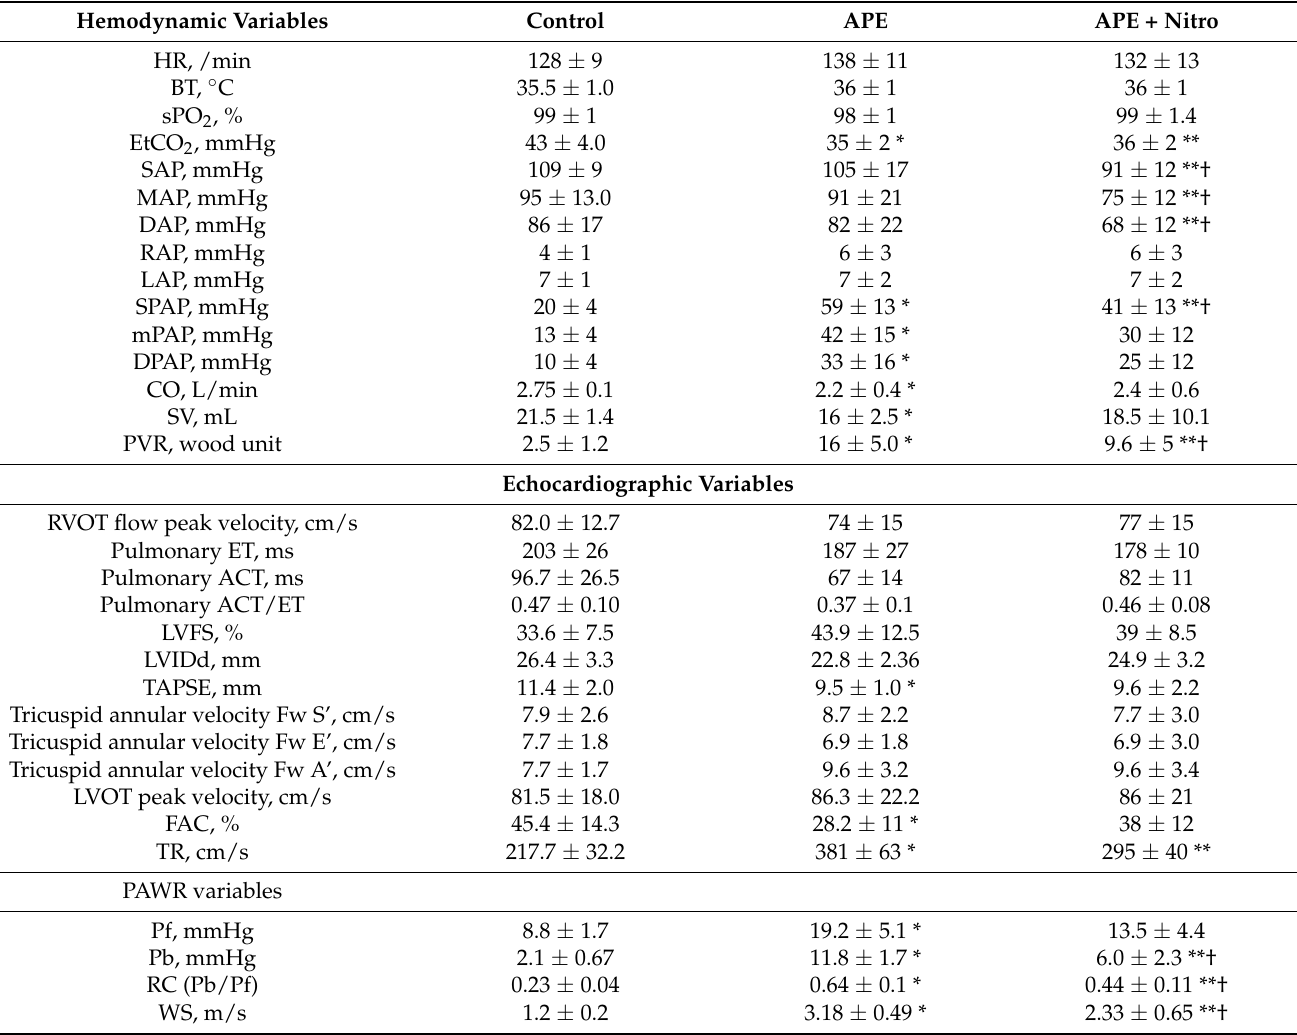
Table 1. Hemodynamic, echocardiographic and pulmonary artery wave reflection